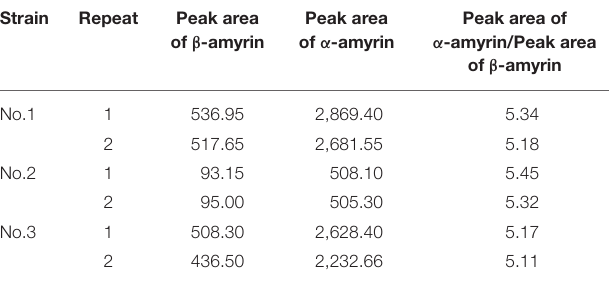
TABLE 5 | Productions of α -amyrin, β -amyrin by the different Yeast transformant carrying IpAS 1 ( n = 2). Strain Repeat Peak area of β